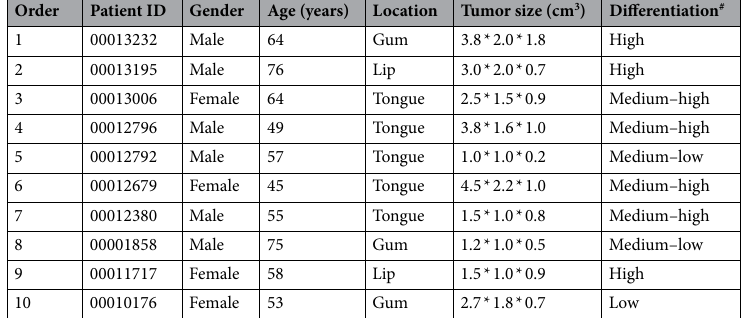
Table 4. Histopathological characteristics of the OSCC patients. IHC immunohistochemistry. # Diagnosed by two experienced